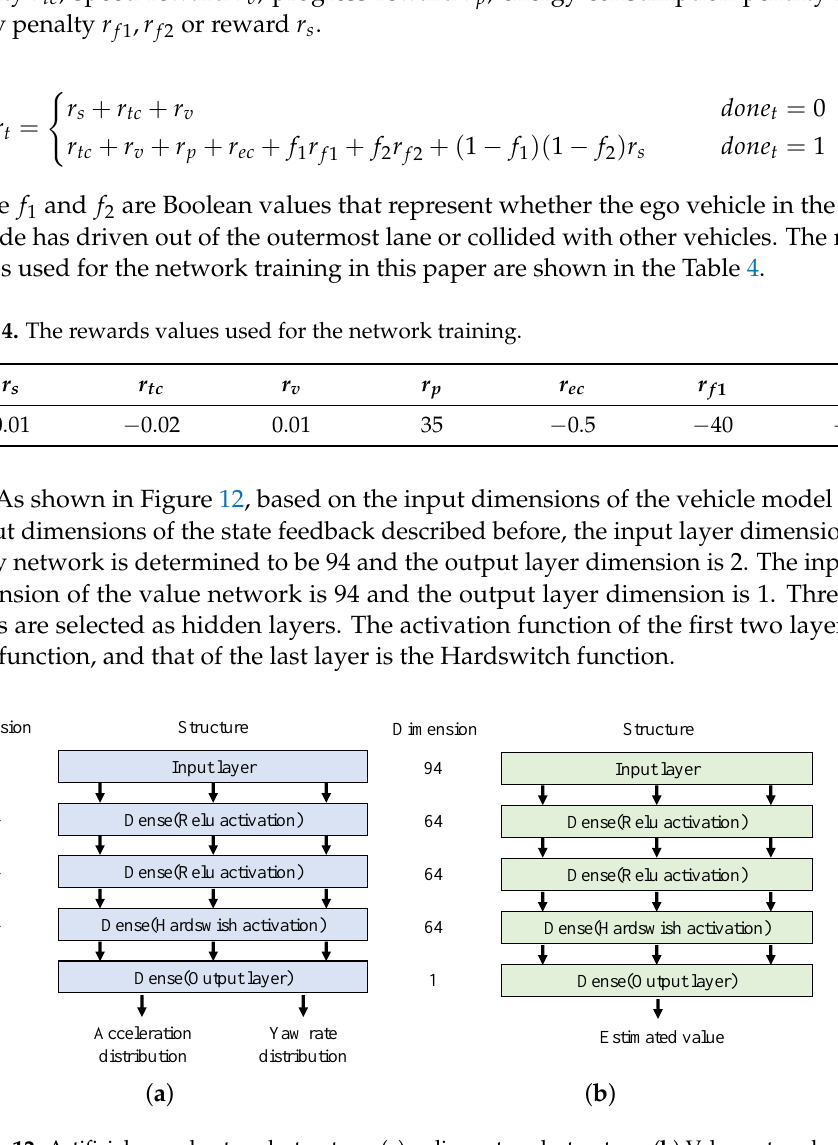
Figure 12. Artificial neural network structure: ( a ) policy network structure. ( b ) Value network structure. The policy network is trained according to the above network structure and parameter settings, and the convergence curve is shown in Figure 13. During the training process, the parameters are updated 2 8 times after collecting 2 14 frames of experience data, and the average reward under the current network parameters, as well as the historical maximum reward are recorded. The model parameters that produce the historical maximum reward are saved and used as the parameters of the final output policy network